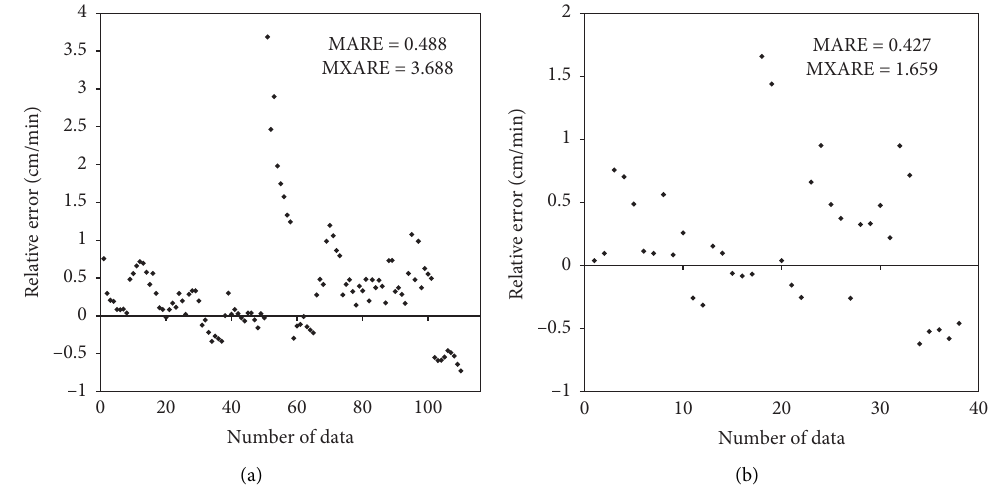
Figure 5: Relative error plots for Philip’s model for the training and testing